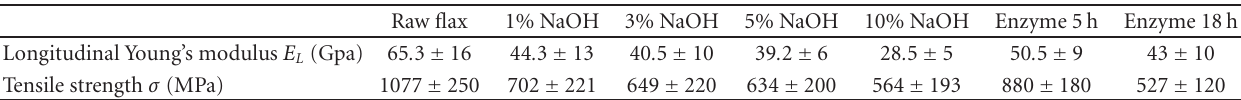
Table 1: Comparison of Young’s modulus ( E L ) and tensile stress ( σ ) of raw-, NaOH-, and enzyme-treated flax fibres measured by single fibre tension test.